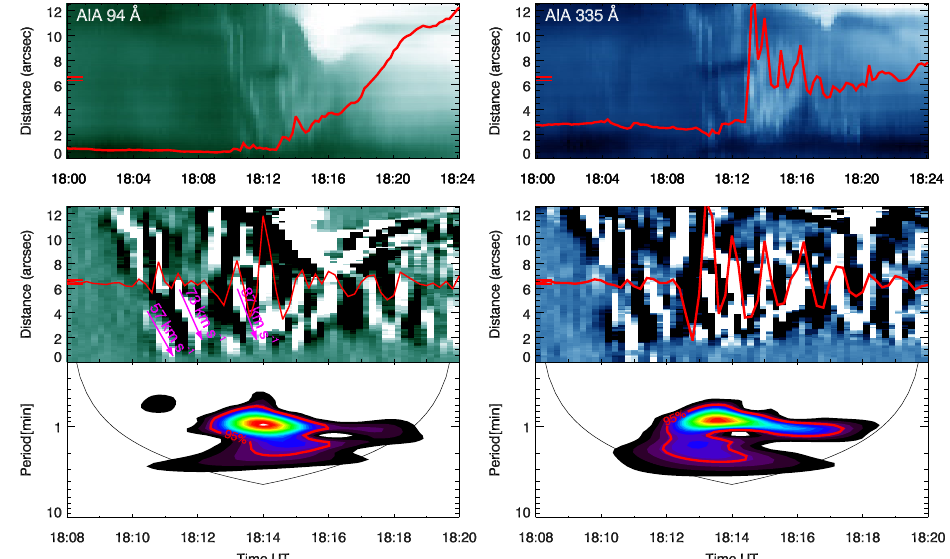
Figure 7. Top panels: time-distance diagrams of the S1 marked in Figure 3g at AIA 94 ˚A ( left ) and AIA 335 ˚A ( right ) , and the red curves represent the light curves between two horizontal red lines on Y-axis. Middle panels: the smooth-subtracted images of top panels. Red curves represent the fast-varying components between two horizontal red lines on Y-axis. The arrows and numbers label the various jets and their speeds. Bottom panels: the wavelet spectra of the red curves. The red contours represent a significance level of 95%.